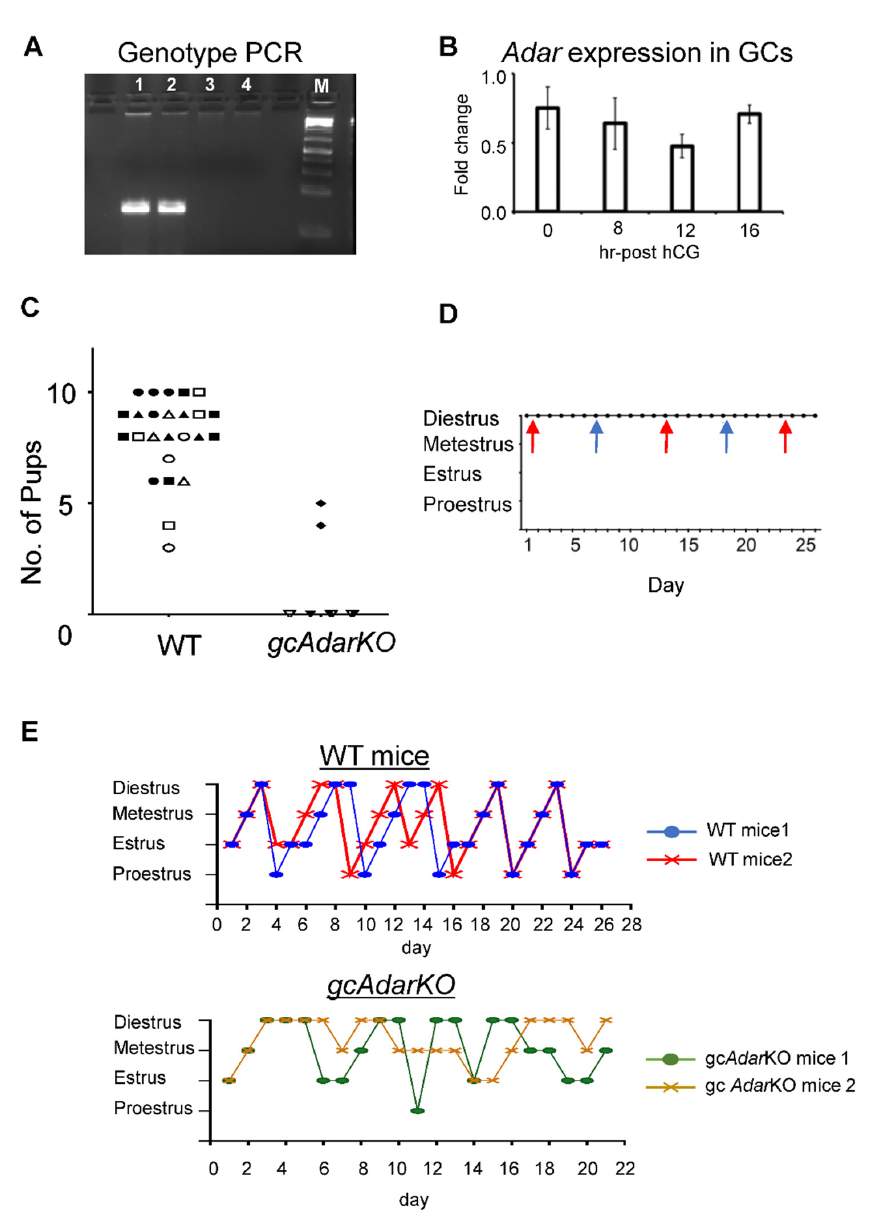
Figure 1. Granulosa specific Adar knockout leads to infertility ( A ) Genotyping PCR was performed using Adar deletion specific primers in granulosa cells from control (lanes 1 and 2) and gc Adar KO mice (lanes 3 and 4). ‘M’ represents DNA ladder. ( B ) Adar expression in ovarian granulosa cells at different time points post-hCG was determined using RT-qPCR. The expression was normalized with 18S rRNA. ( C ) Pups per litter from wild-type littermate control mice (n = 6) and gc Adar KO (n = 5) were counted over a 7-month period. Individual mice are indicated by unique icons. Each litter is plotted by the number of pups counted or placed at zero to indicate no litters were ever observed. ( D ) Estrous stage for representative gc Adar KO breeding trial mice as determined by vaginal cytology, presence of seminal plugs is indicated by arrows, (different colors represent individual animals, n = 2 shown of the 5). ( E ) Estrous cycle stages for representative wild-type and gc Adar KO females analyzed by vaginal smears collected from 42-day old mice for at least 21 days. Smears were stained with crystal violet staining and staged based upon cytology. Representative graphs for 2 WT and 2 gc Adar KO are shown. Wild-type mice displayed cyclical estrous patterns, while gc Adar KO had disrupted cycling with prolonged periods of diestrus and